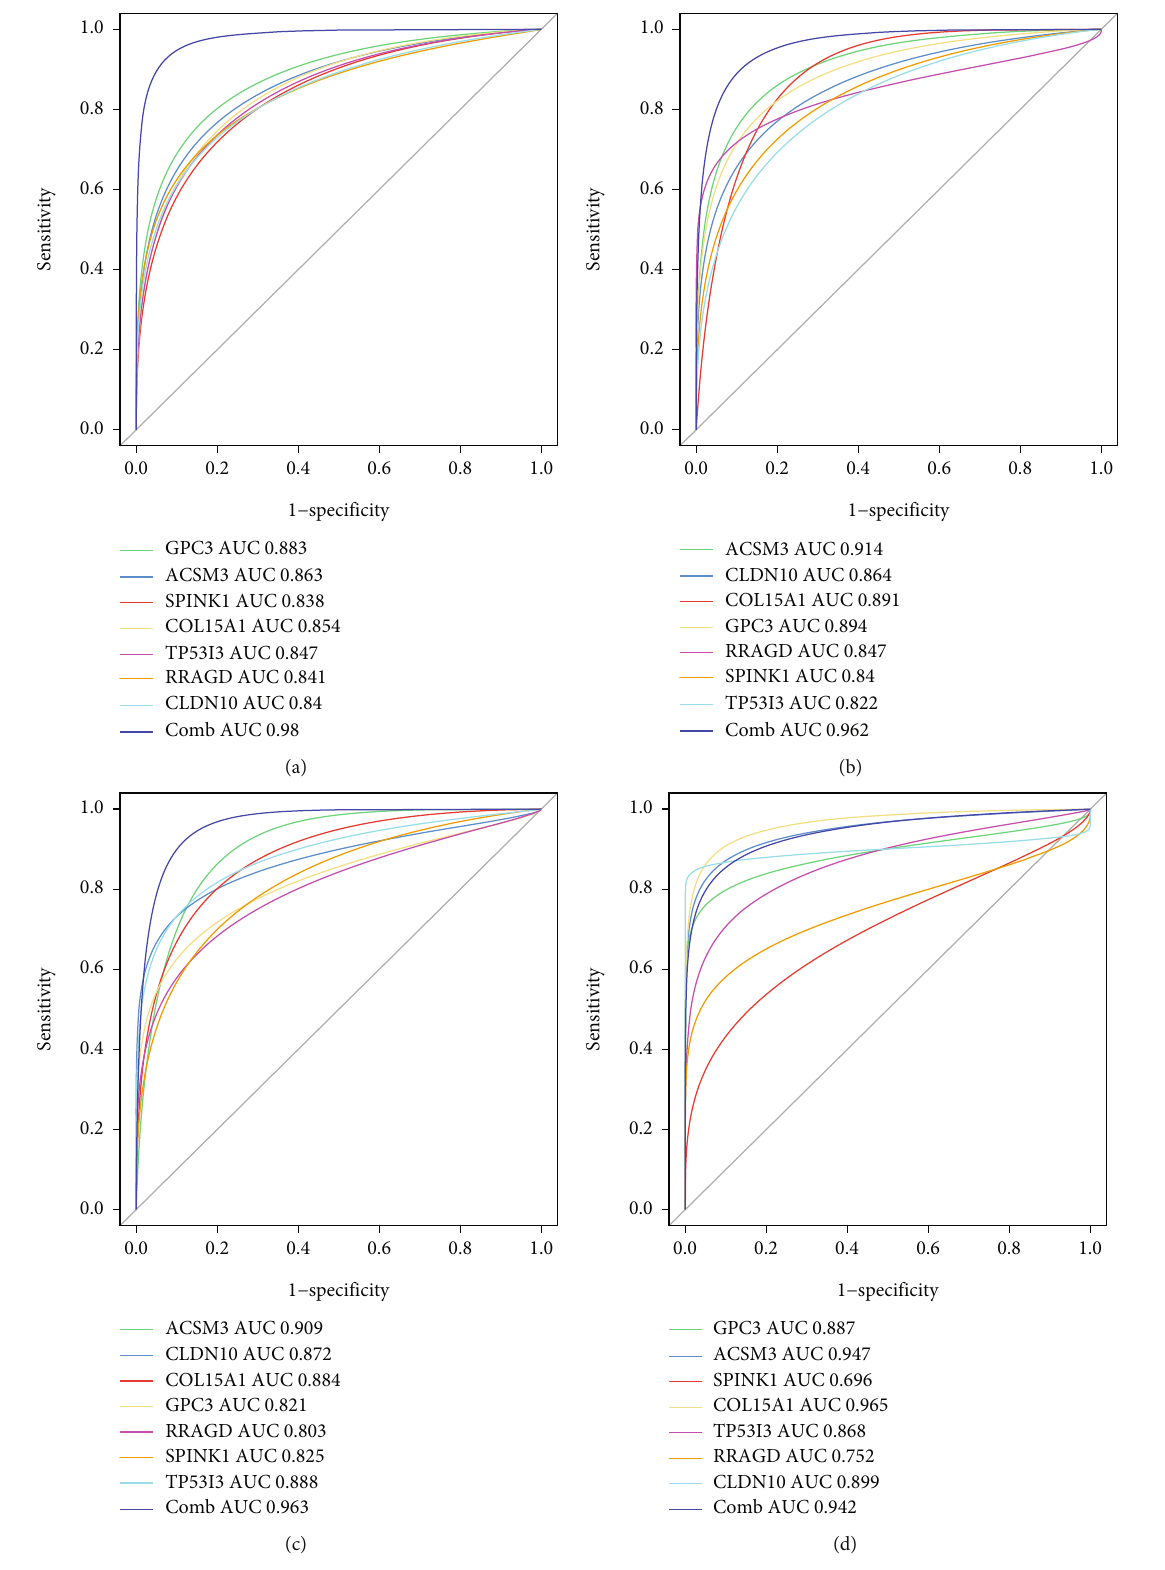
Figure 5: The ROC curve of the discrimination ability of the seven identi fi ed diagnostic gene biomarkers in di ff erent cohorts. (a) The discovery cohort. (b) GSE14520-GPL3921 cohort. (c) ICGC-LIRI-JP cohort. (d) The TCGA